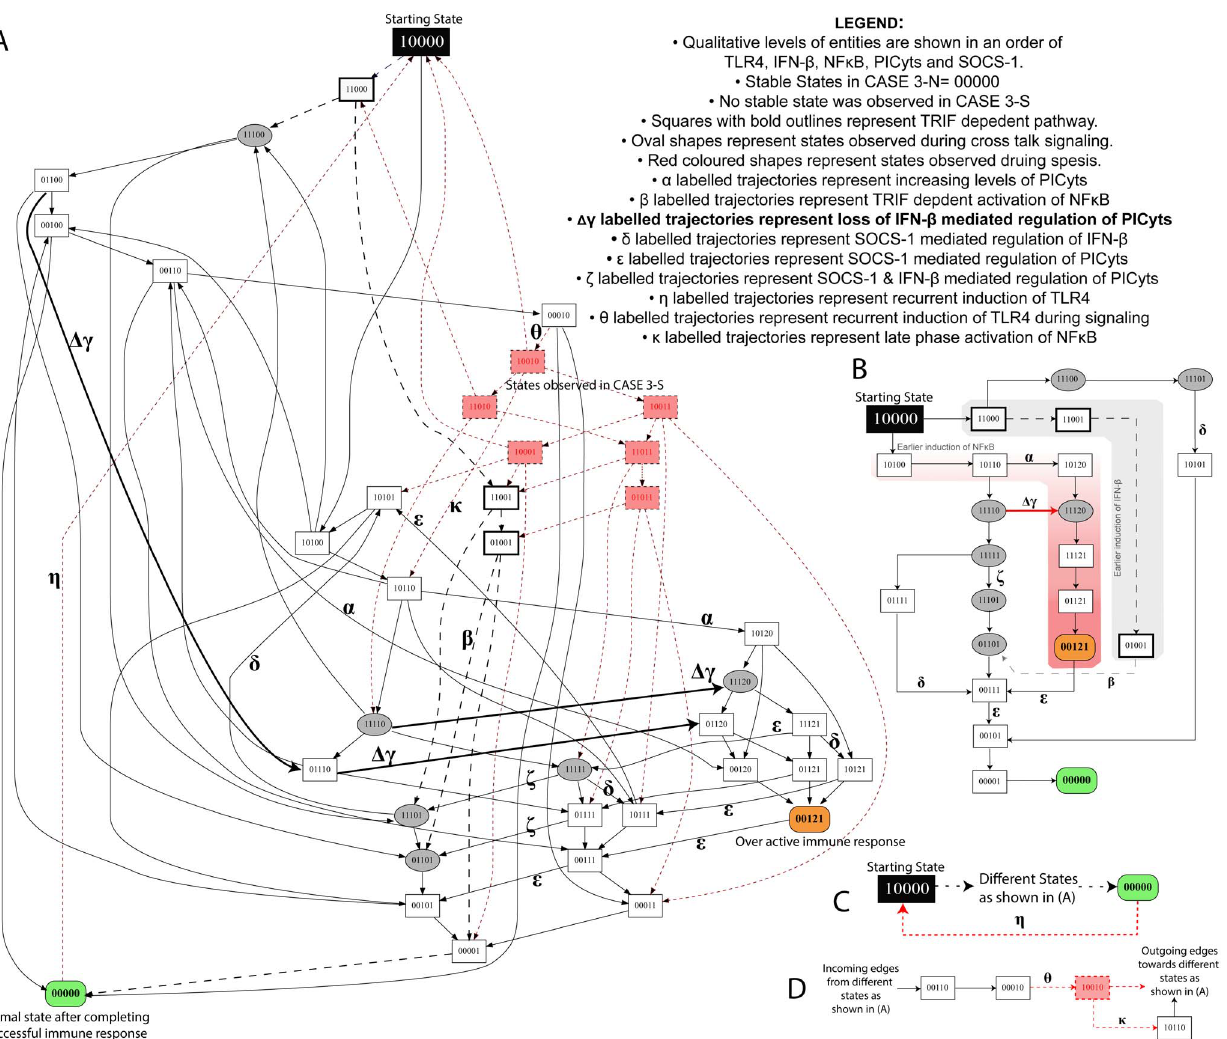
Figure 6. State graph of CASE 3-N and 3-S. (A) Each node represents a particular state observed during signalling associated with CASE 3-N and CASE 3-S. Integers ‘‘0’’, ‘‘1’’ and ‘‘2’’ within the nodes represent qualitative levels of proteins in the order of TLR4, IFN- b , NF k B, PICyts and SOCS-1. Inactive entities are represented by integer ‘‘0’’ whereas active and overactive entities are represented by integers ‘‘1’’ and ‘‘2’’, respectively. Nodes and trajectories, which were specifically observed during signalling dynamics associated with CASE 3-S, are shown in red, whereas common nodes and trajectories found in both CASES are shown in black. Trajectories start from state ‘‘10000’’, representing the activation of TLR4, ultimately, lead towards ‘‘00000’’, which is the stable state in CASE 3-N. On the other hand, a trajectory labelled with ‘‘ g ’’ from state ‘‘00000’’ to starting state ‘‘10000’’ results in a cyclic path during signalling dynamics associated with CASE 3-S. Trajectories associated with loss of IFN- b mediated downregulation of PICyts in CASE 3-N and CASE 3-S are presented as bold arrows labelled with symbol ‘‘ Dc ’’. MyD88 and TRIF dependent signalling are shown as black lines and dashed arrows, respectively. Nodes, which represent crosstalk of both signalling pathways i.e. IFN- b and NF k B with qualitative level ‘‘1’’ are presented in oval shapes. Arrows labelled with Greek small letters are used to represent trajectories associated with different signalling events (see legend in the figure). The conditions necessary to produce a state graph shown in the figure are given in Table 3. (B–D) specific states and trajectories which can possibly represent the complete state graph given in